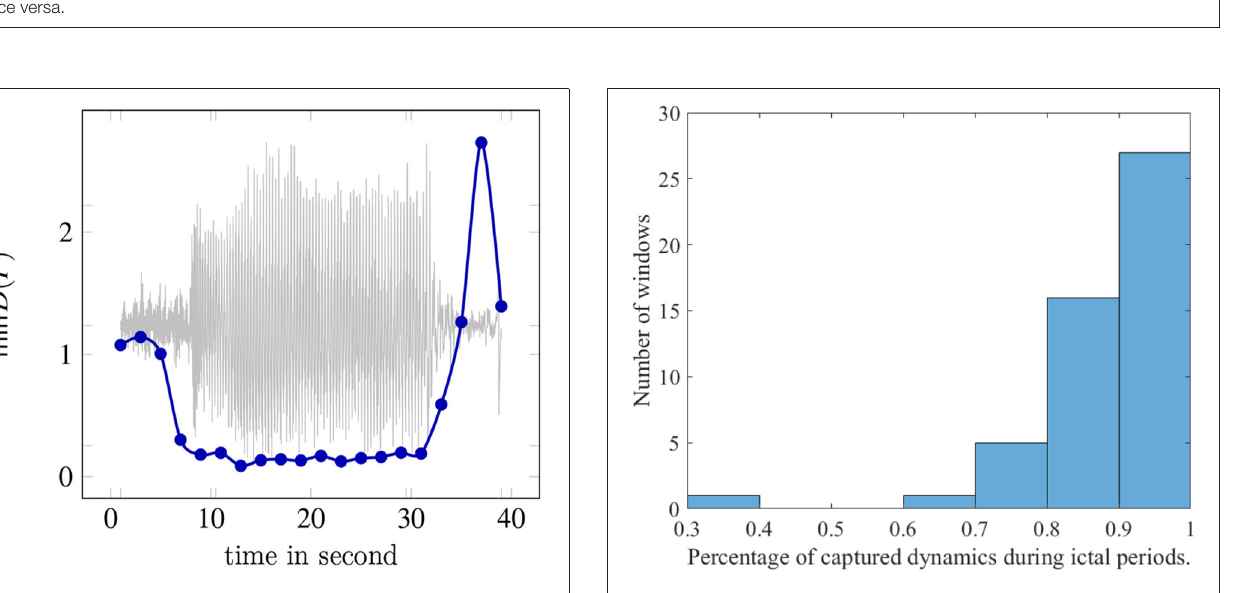
FIGURE 2 | Minmal values of the cost function of DSBM (7) on a two-second-windowed data set. In the background the signal of the F4 electrode is shown.